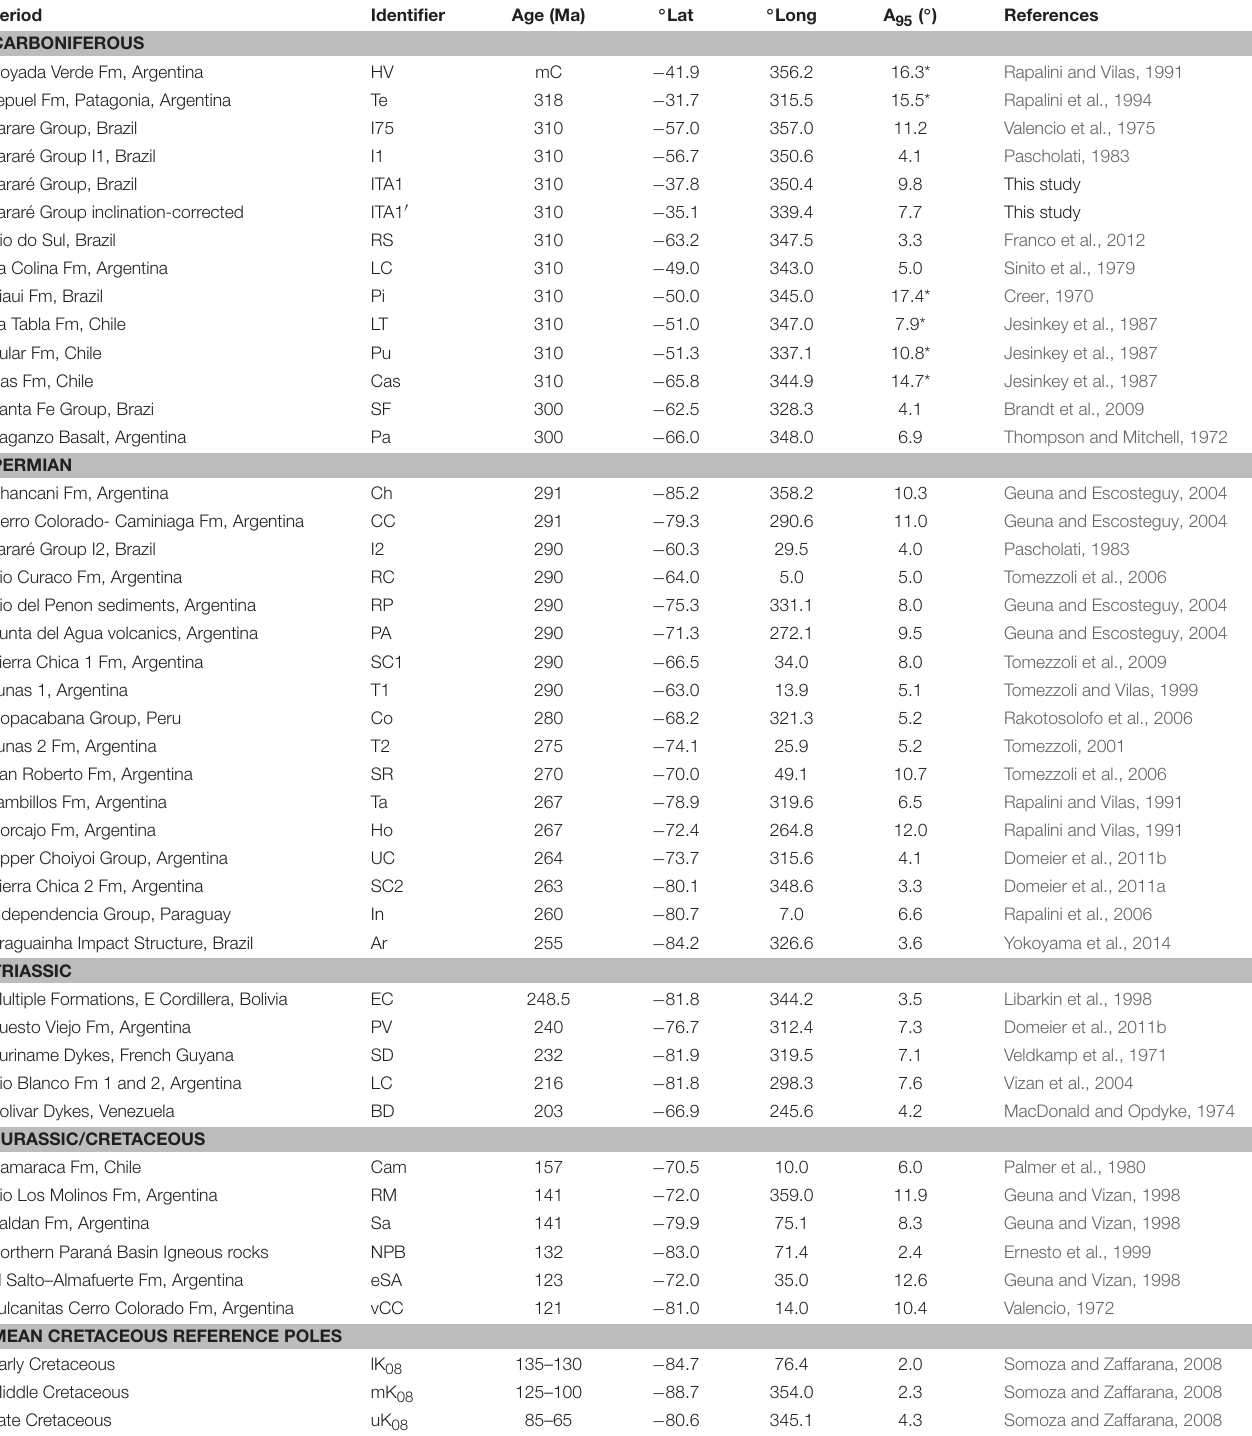
TABLE 2 | South paleopoles, as reported in the literature, utilized in this study and separated by age: Identifiers correspond to the labels used in Figure 9 ; Ages are reported in Ma; degrees latitude, degrees longitude; A 95 is 95% circle of confidence around the mean of the VGPs; *A 95 was recalculated because not reported in the original study [either the α 95 (La Tabla, Pular, Cas), the dm-dp (Hoyada Verde, Tepuel), or the csd (Piaui) of the directions were